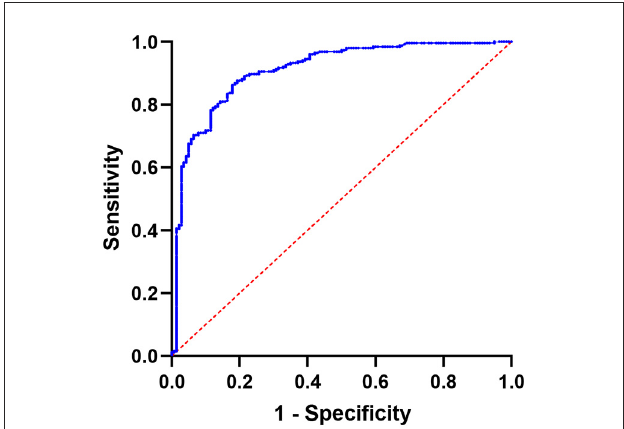
FIGURE4 Box plots of all lesions in relation to the SUVmax (g/ml) for osteoblastic, osteolytic, mixed, and CT-negative metastatic lesions.